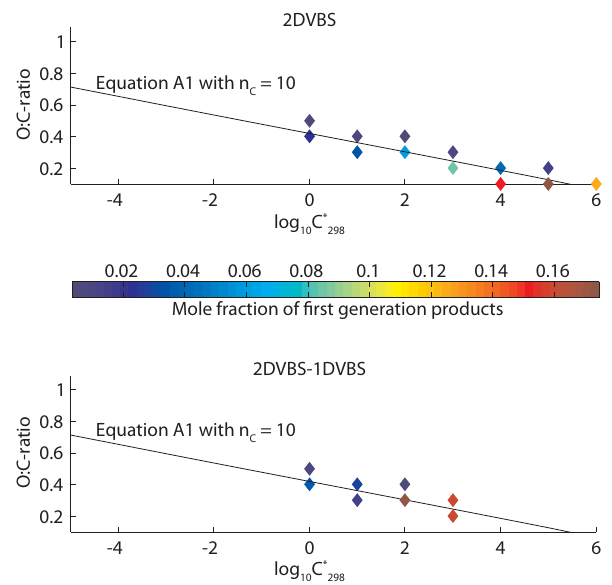
Figure 8. First-generation product distribution in the two- dimensional VBS space modeled with the 2DVBS simulation (up- per panel) and the 2DVBS-1DVBS simulation (lower panel). The black line shows the linear dependence between the O:C ratio and volatility when a carbon number of 10 is